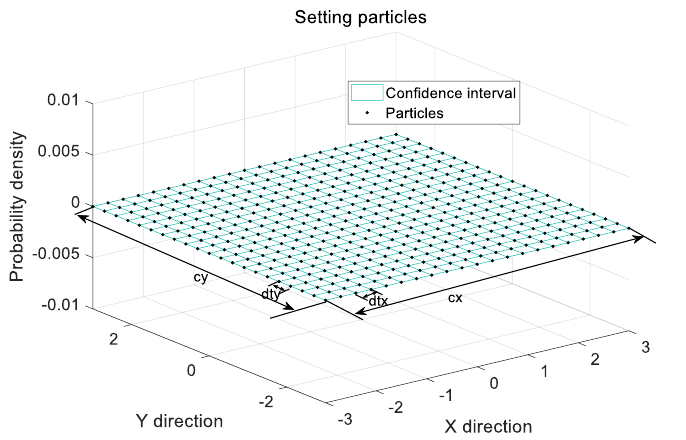
Figure 1. Sketch map of setting particles.